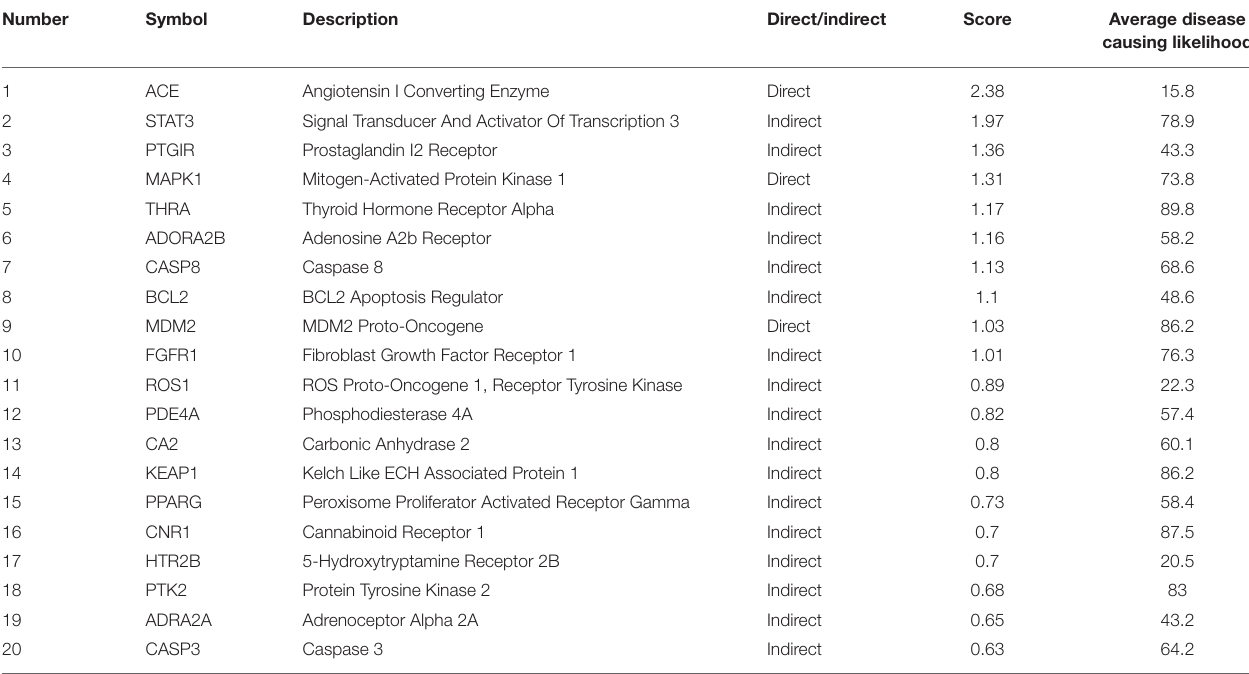
TABLE 4 | Top 20 targets directly or indirectly associated with the HO phenotype.